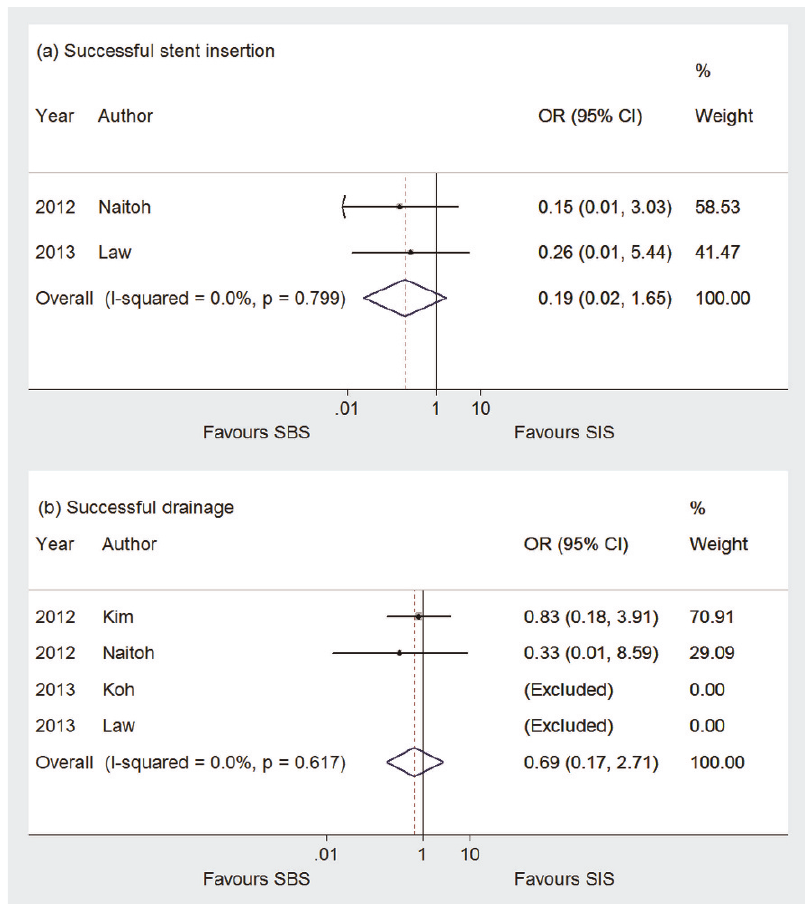
Figure 1 - A comparison of the successful stent insertion rate (a) and the successful drainage rate (b) between the SBS and SIS